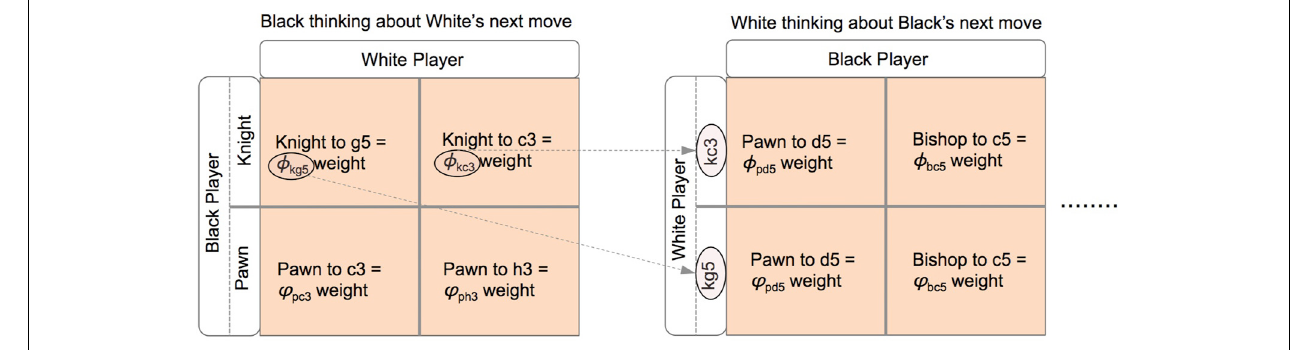
FIGURE 6 | A matrix representation of the estimated weights that Black uses to analyze their next move (left) and how White will respond to each of these moves and the rational that White will use to evaluate their subsequent choices given Black’s prior choices (right). In order for